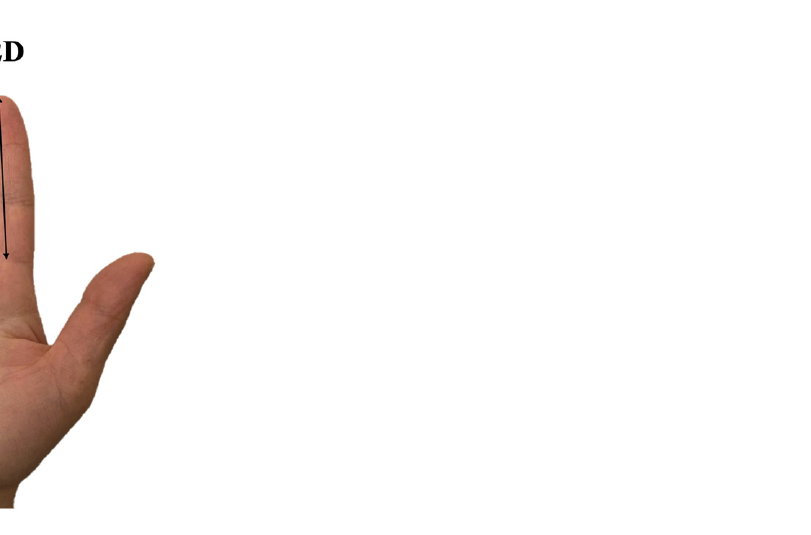
Figure 1. The 2D:4D ratio is calculated by dividing the length of the index finger of a given hand by the length of the ring finger of the same hand.